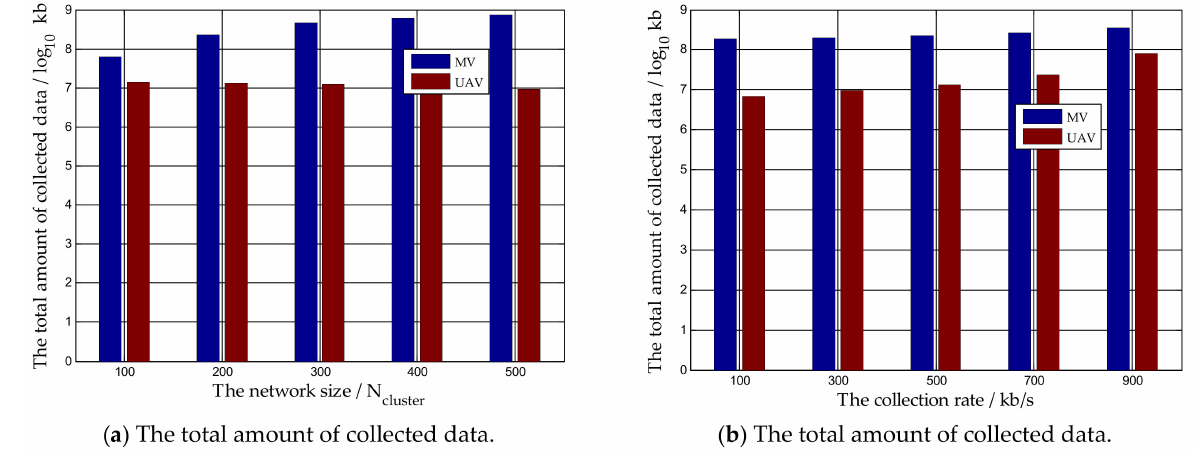
Figure 6. The influences of different parameters on the amount of collected data by our